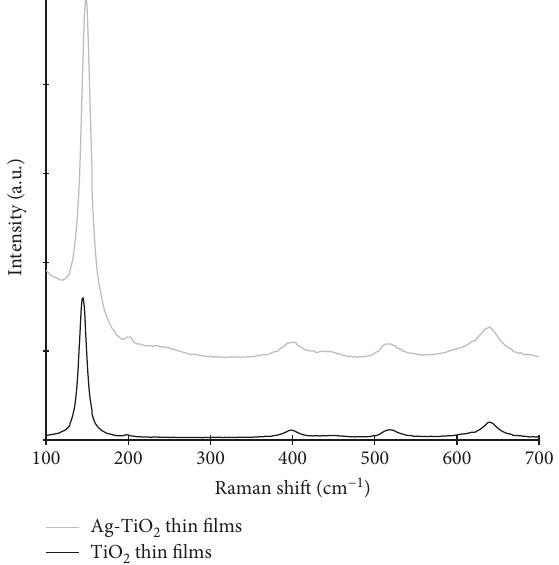
thin fi lms and Ag-TiO 2